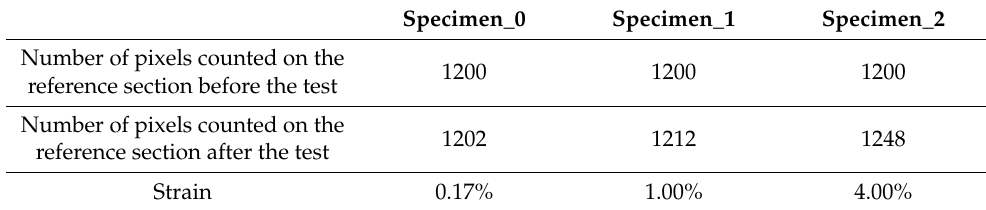
Table 1. Results from the experiment.